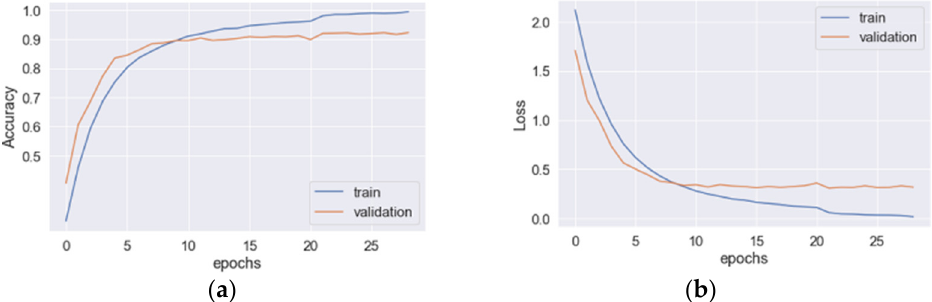
Figure 3. The learning curves for the hybrid CNN+LSTM model: ( a ) the accuracy and ( b ) loss curves.